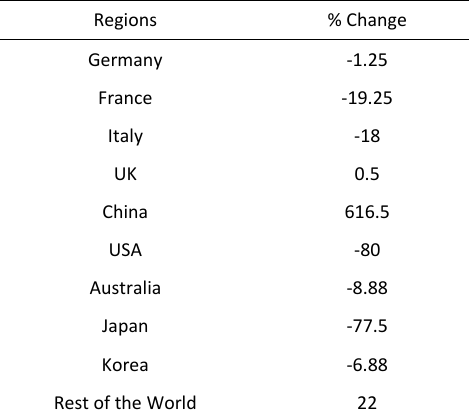
Table 4: Real gross domestic product changes (% change)